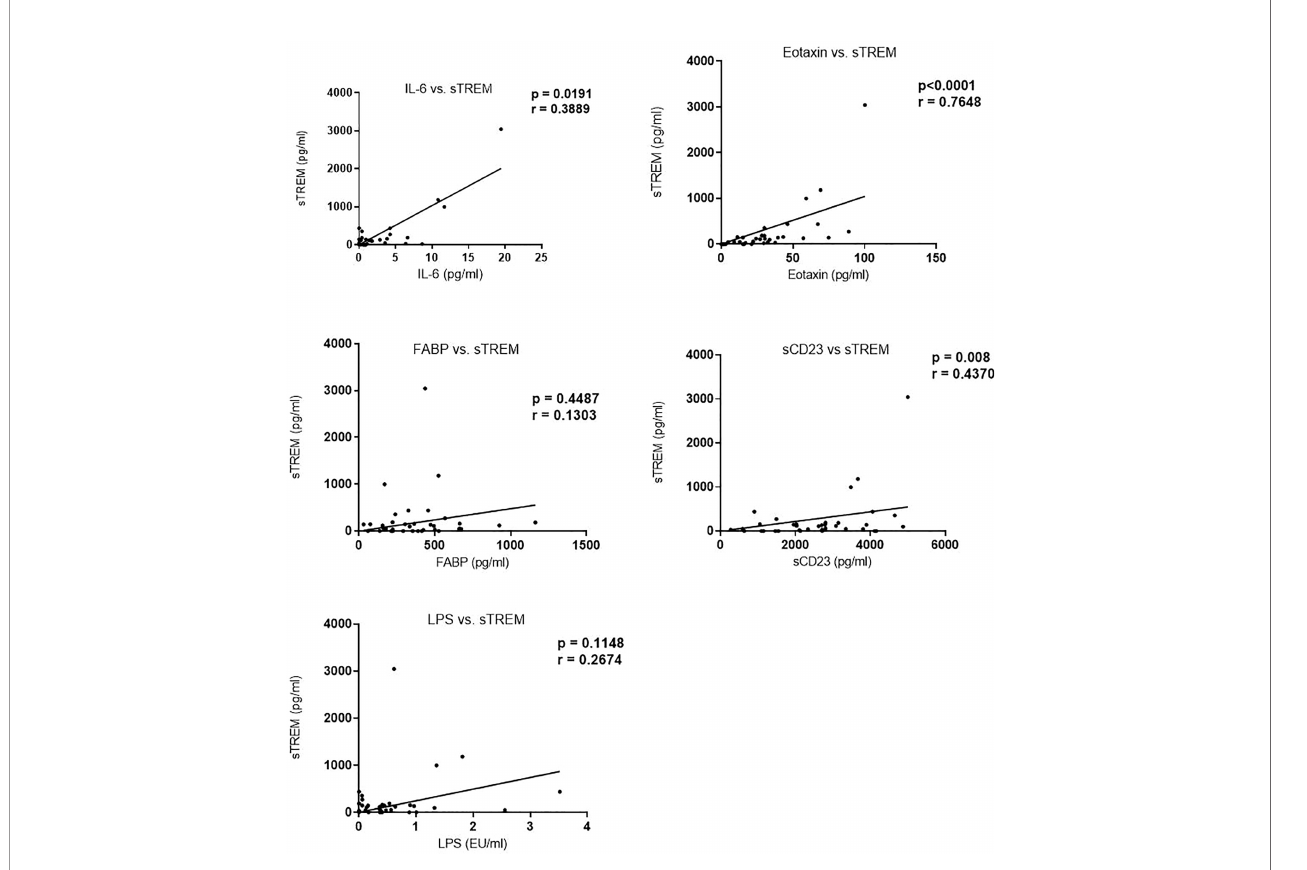
FIGURE 2 | Correlation between sTREM and other biomarkers in children in western Kenya. Data plotted are those with corresponding values (n = 36) for each of the biomarkers. sTREM, soluble triggering receptor expressed on